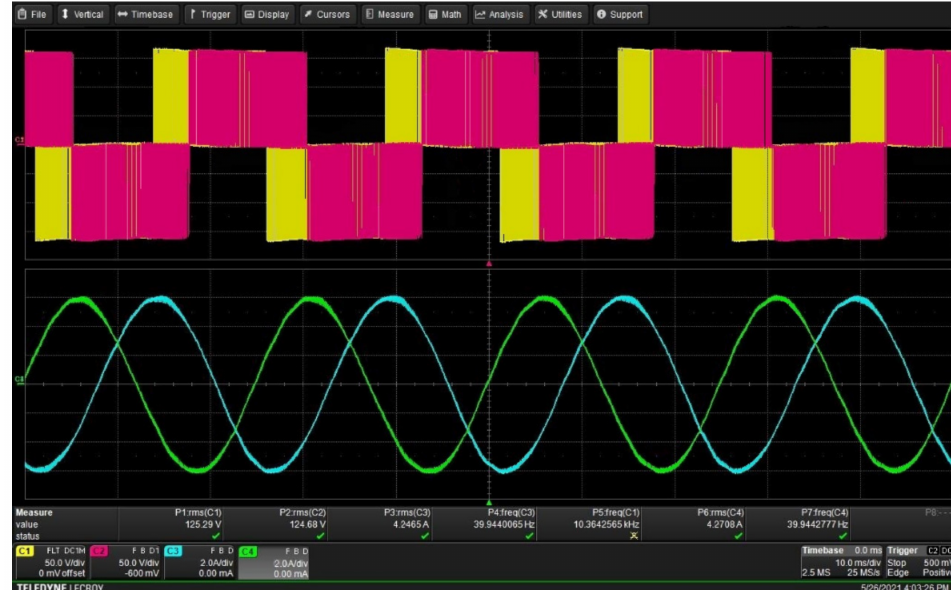
Figure 16. Experimental results of voltage and current at the output of the modular three-phase VSI, steady state (50 V/div, 2 A/div, 10 ms/div).